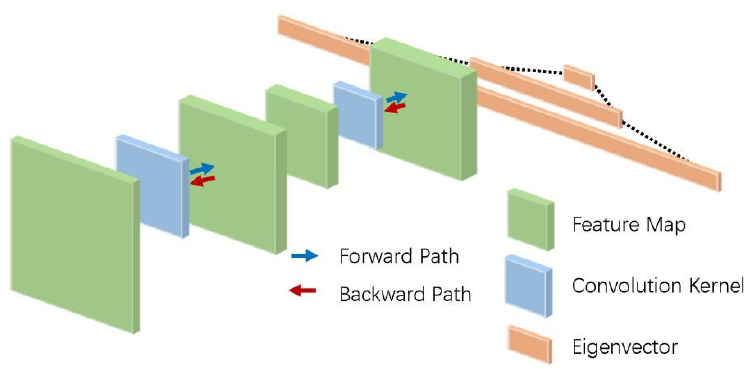
Figure 6. Structure of LeNet-5.